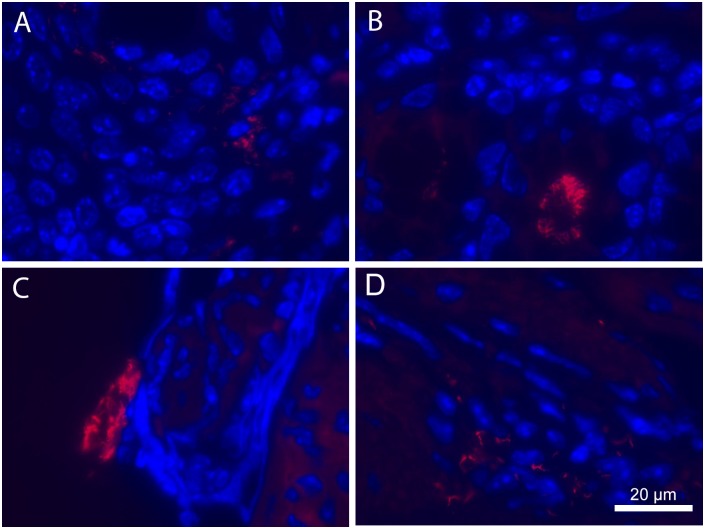
Fluorescent in situ Hybridization on lower bowel of Lpd-/- mice.(A) The colo-rectal junction region of a clinically normal, EHS-positive mouse showing organisms adjacent to host cells in the distal GI tract; (B) Typical positive staining showing heavy colonization within the crypts of the colon; (C) Rectum of the same animal in B with organisms detected along the surface of abnormal prolapsed tissue; (D) Another prolapsed rectum with EHS dispersed within the abnormal edematous tissue. A combination of two genus-specific probes, HEL274 and HEL717, labeled with Cy3 were used. Magnification = 630x; bar = 20μm.